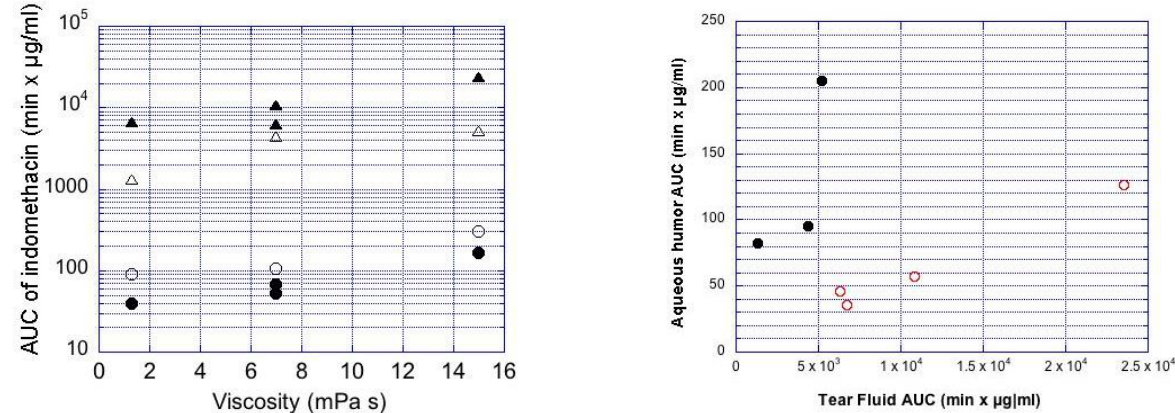
Figure 4. Left : Ocular indomethacin pharmacokinetics in the rabbits. AUC values for mean indomethacin concentrations in the aqueous humor (circles) and tear fluid (triangles) are shown. The clear symbols describe the data from small (mean size 0.4–1.3 µm) suspension particles, and the filled symbols are for the large particles (mean size 3.1–3.5 µm) at three different viscosity levels ( x -axis). Right : Plot of AUC in aqueous humor vs. AUC in tear fluid. The filled symbols are for the larger particles (mean size 3.1–3.5 µm) and clear symbols for the smaller particles (mean size 0.4–1.3 µm). Indom is included as medium viscosity formulation with large particles in both figures.